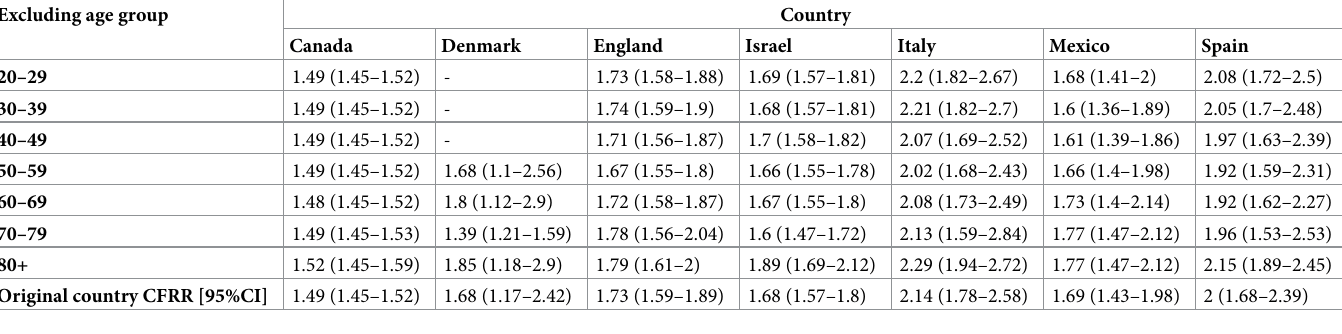
Table 3. Sensitivity analysis of the pooled CFRRs for each country by removing each age group at a time. Excluding age